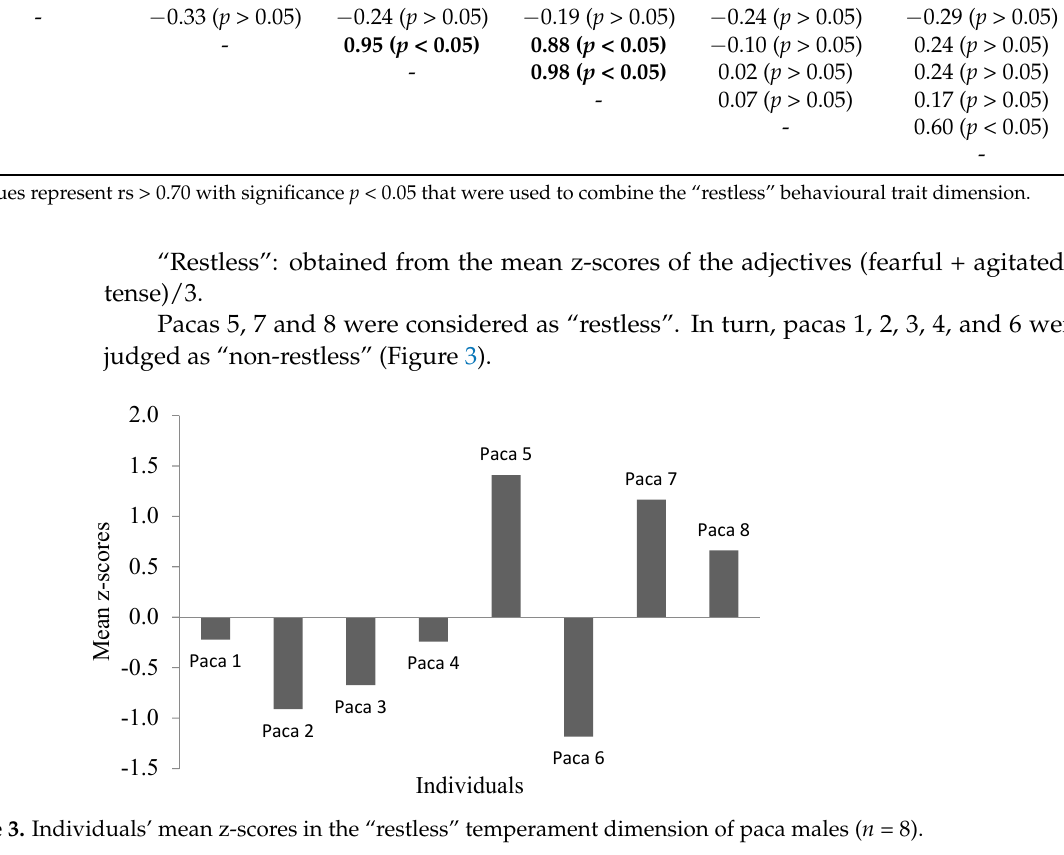
Table 4. Spearman’s coefficient of correlations (r Spearman values) * among the mean ratings of selected adjectives. Active Fearful Agitated Tense Bold Curious